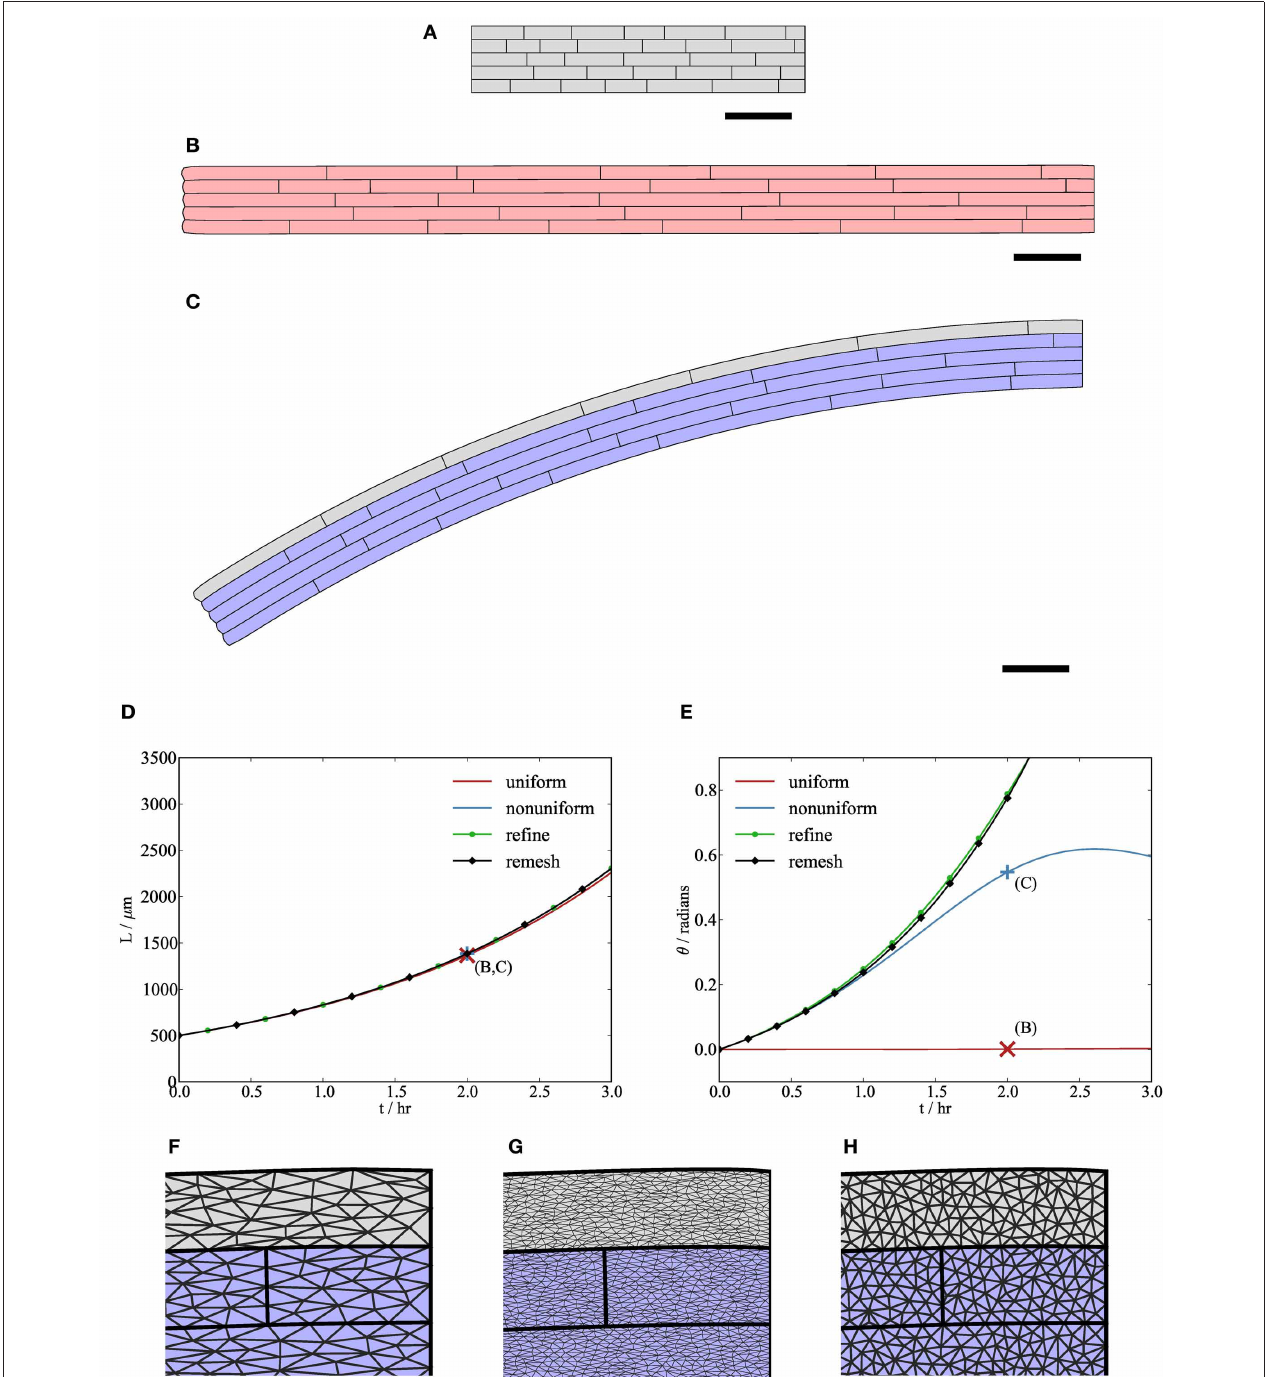
FIGURE 6 | Variations in cell mechanical properties lead to organ-scale bending. (B,C) Simulation results at t = 2hr with initial synthetic geometry (A) . The gray cells in the uppermost file of the organ in (C) have slightly lower isotropic viscosity ( μ 1 = 0 . 13MPahr) than the other cells in (B) and (C) ( μ 1 = 0 . 15MPahr). (D,E) The total length of the midline of the organ L and the angle θ made between the tip and the x -axis, respectively. Initially, both organs grow roughly exponentially; however, the bending rate may decrease